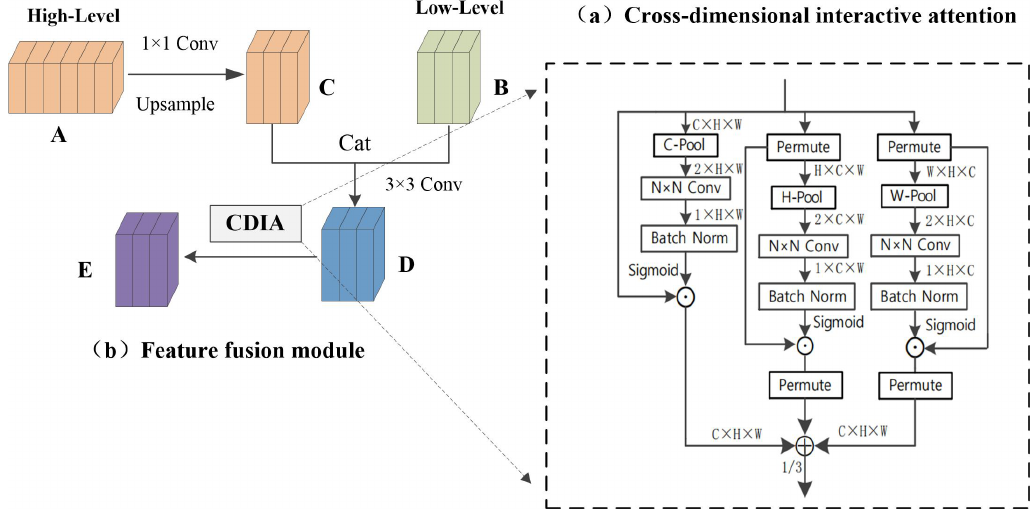
Figure 5. Cross-dimensional interactive attention feature fusion module